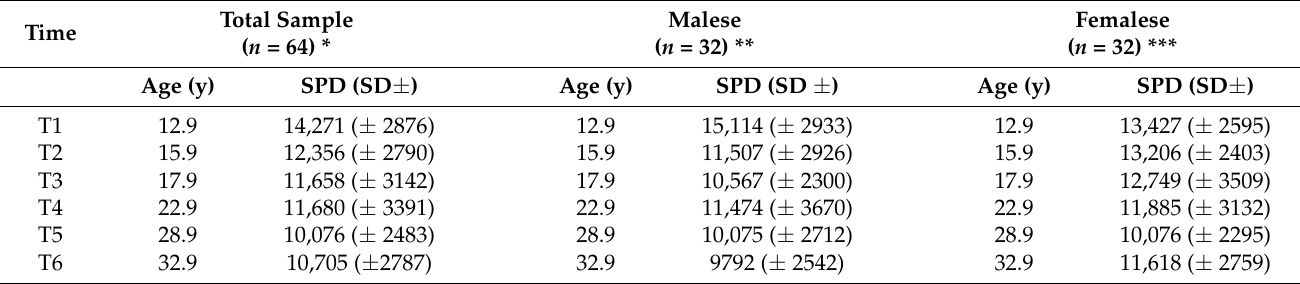
Table 1. Descriptive data for participants (numbers and age), and mean (SD ± ) steps per day (SPD) at T1 (2000), T2 (2003), T3 (2005), T4 (2010), T5 (2016), and T6 (2020) in the total sample, and stratified by males and females, respectively. Time